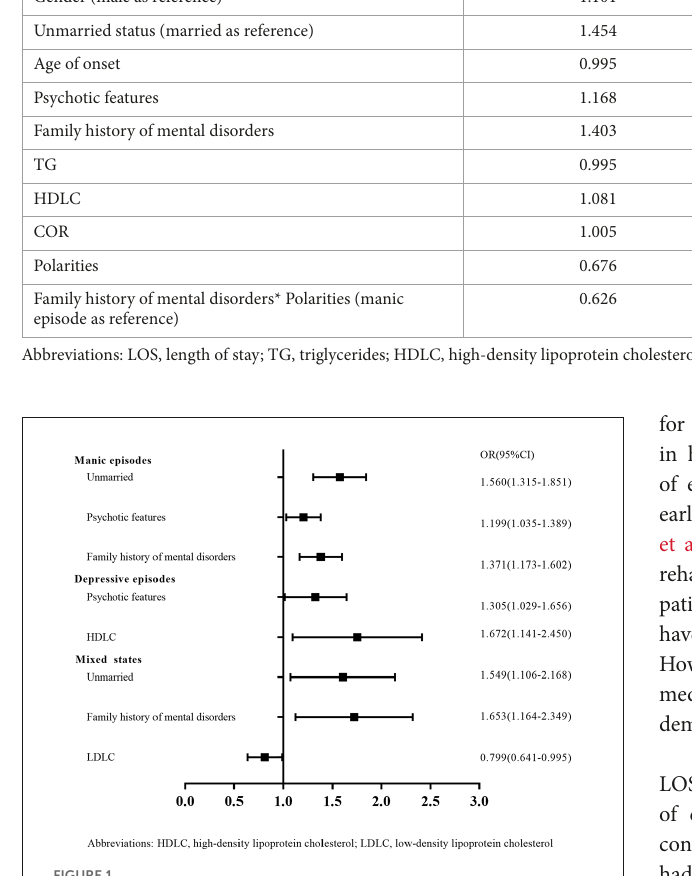
FIGURE1 Forest plots depicting logistic regression results of LOS in the three polarities. Abbreviations: HDLC, high-density lipoprotein cholesterol; LDLC, low-density lipoprotein cholesterol; LOC, length of